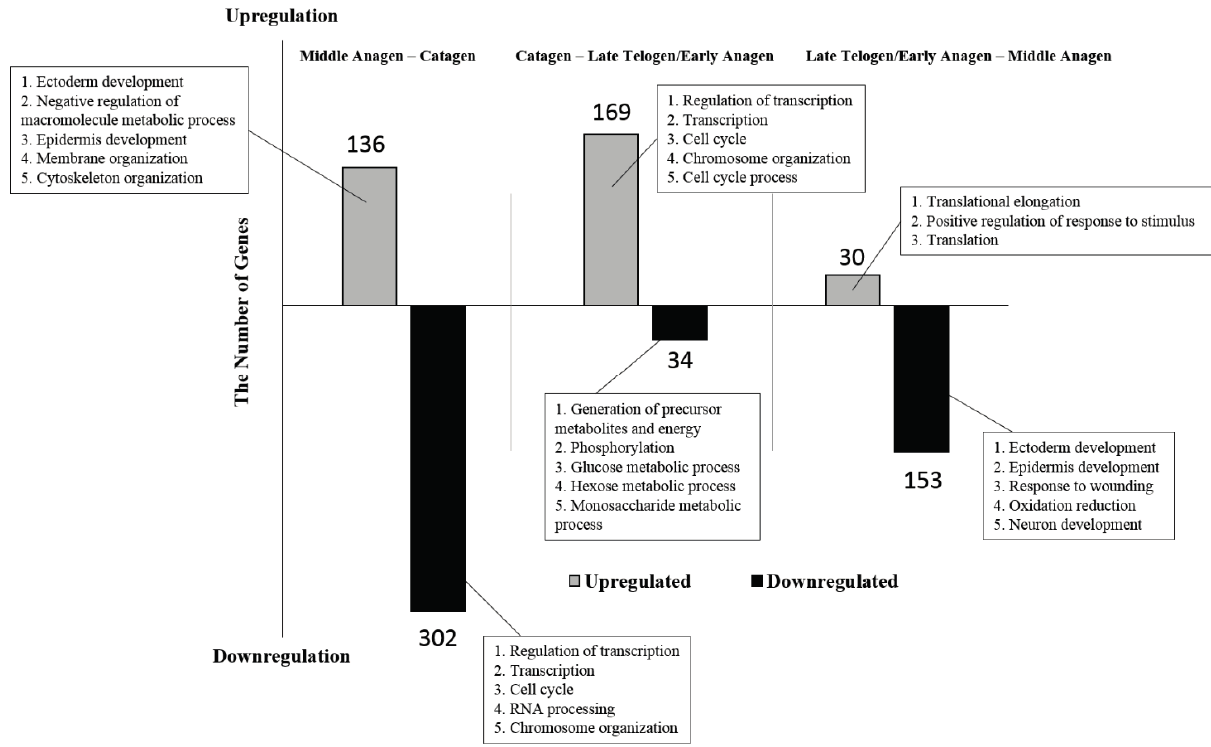
Figure 3. The differentially expressed genes during wool follicle phase transformation. A total of 438 genes (136 upregulated and 302 downregulated genes, respectively) were identified to be differentially expressed in wool follicle bulb samples from the middle anagen phase compared to the catagen phase. In wool follicle bulb samples from the catagen phase compared to the late telogen/early anagen phase, 203 differentially expressed genes (169 upregulated and 34 downregulated genes, respectively) were identified. Additionally, 175 genes (30 upregulated and 145 downregulated genes, respectively) showed significant differences in expression level in wool follicle bulb samples from the late telogen/early anagen phase as compared to the samples from the middle anagen phase. The boxes show the first five enriched GO terms for each group of differentially expressed